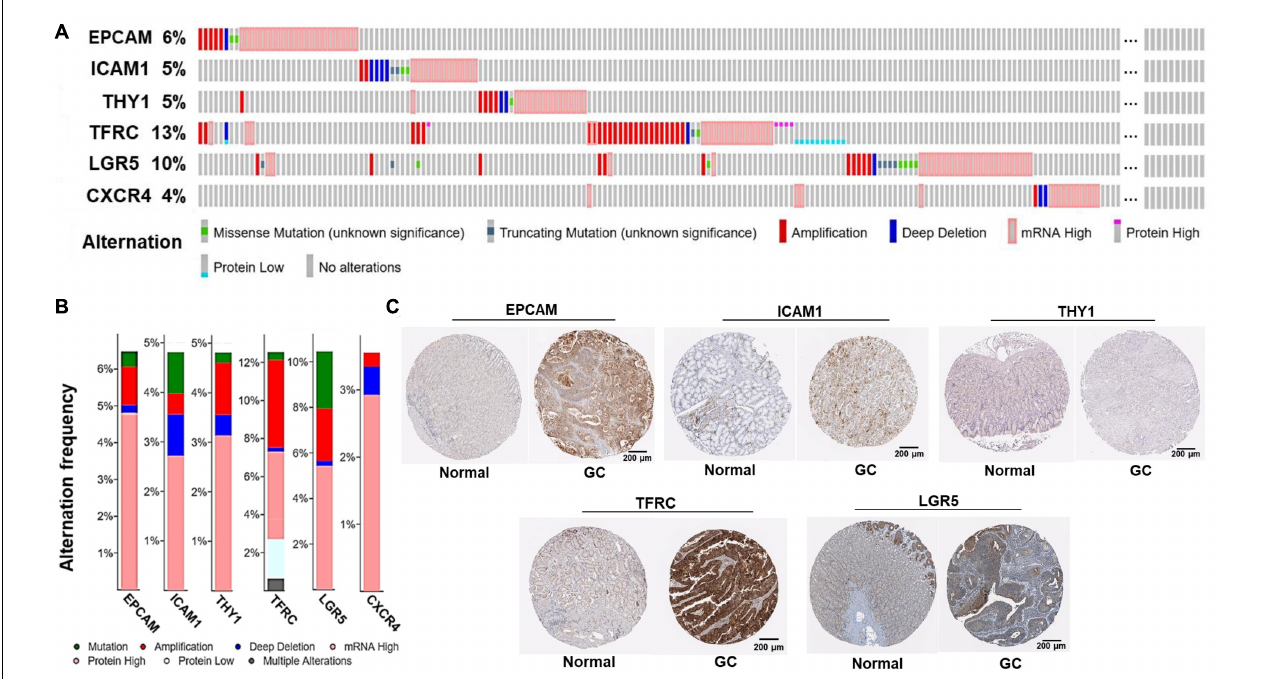
FIGURE 3 | Alternations and protein expression of GCSC markers in GC. (A) An overview of the genomic and proteomic alternations of GCSC markers in GC samples from “TCGA, Firehose Legacy” dataset (cBioPortal). (B) A summary graph of the alternation frequency of GCSC markers in GC samples (cBioPortal). (C) The intensity of IHC staining of GCSC markers in normal stomach and GC tissues (the HPA database). The antibodies for EPCAM, ICAM1, THY1, TFRC, and LGR5 were CAB030012, HPA004877, CAB068244, HPA028598, and HPA012530, respectively. The IHC data of CXCR4 was still in preparation.